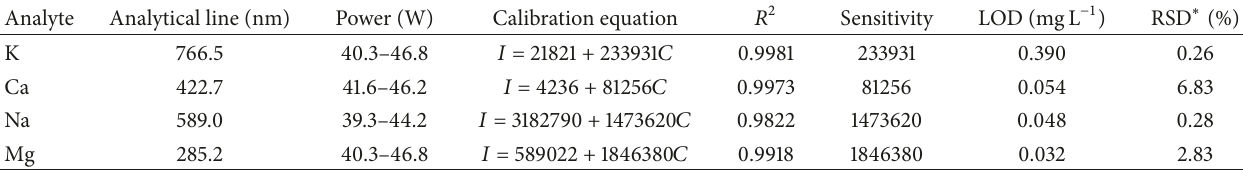
Table 1: Analytical performance of LCGD-AES for K, Ca, Na, and Mg solution.